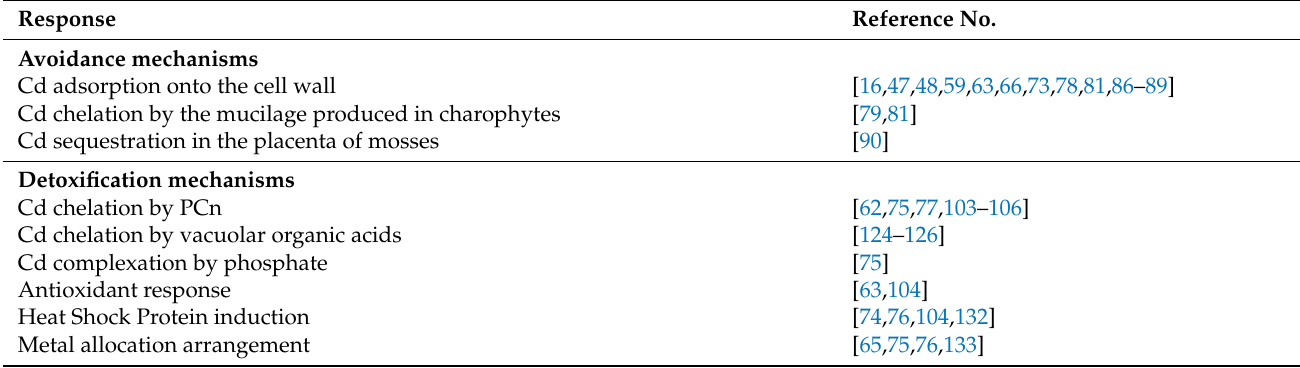
Table 2. Response to Cd toxicity in charophytes and